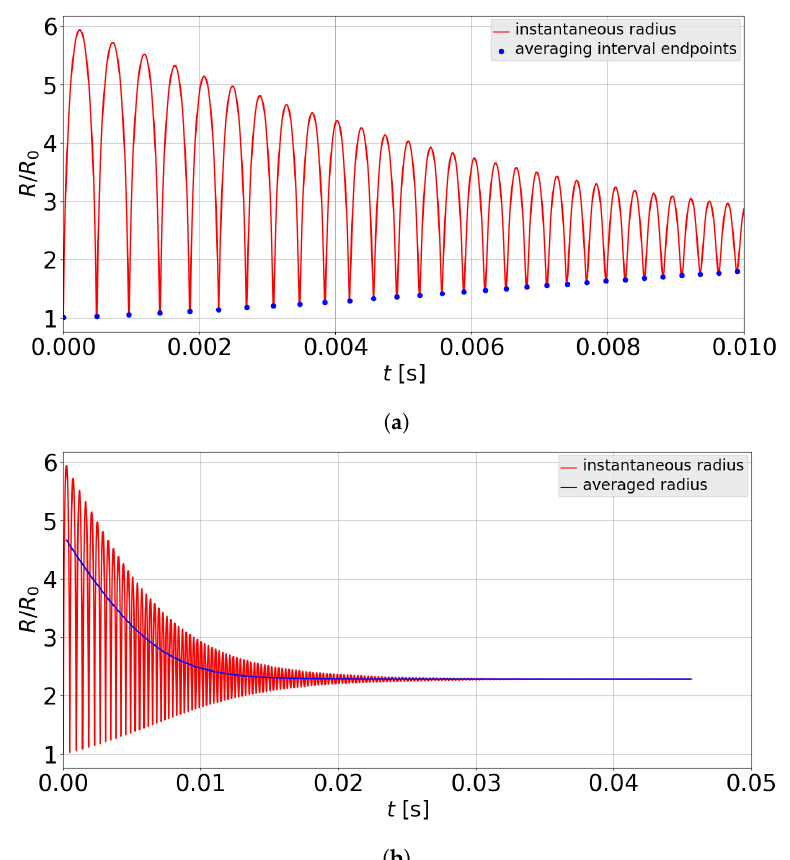
Figure 6. Instantaneous and averaged radius of the bubble for a sudden pressure drop from initial pressure of 0 bar gage pressure to a final pressure of − 0.7 bar gage pressure far away from the bubble interface with the parameters: ν l = 1.3 × 10 − 6 m 2 /s, ρ l = 1000 kg/m 3 , p v = − 0.7 bar gage pressure, σ = 72.75 × 10 − 3 kg/s 2 and ˙ R 0 = 0 m/s—( a ) endpoints of the averaging interval (marked by solid points); ( b ) comparison between instantaneous and averaged